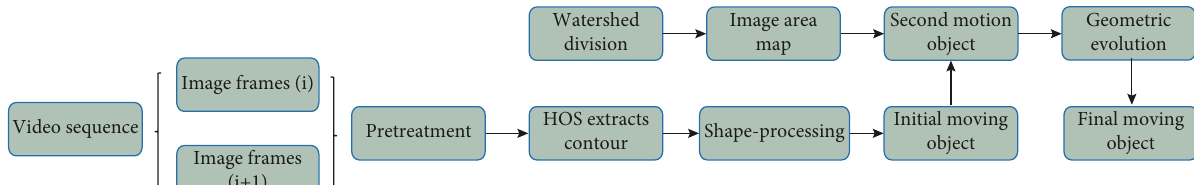
Figure 6: Structure diagram of moving object extraction